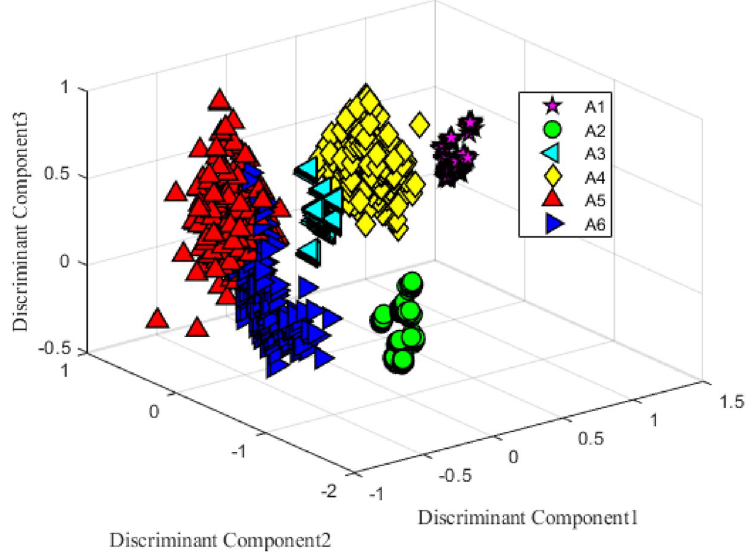
Figure 5. Discriminant analysis projection plot of the samples from six